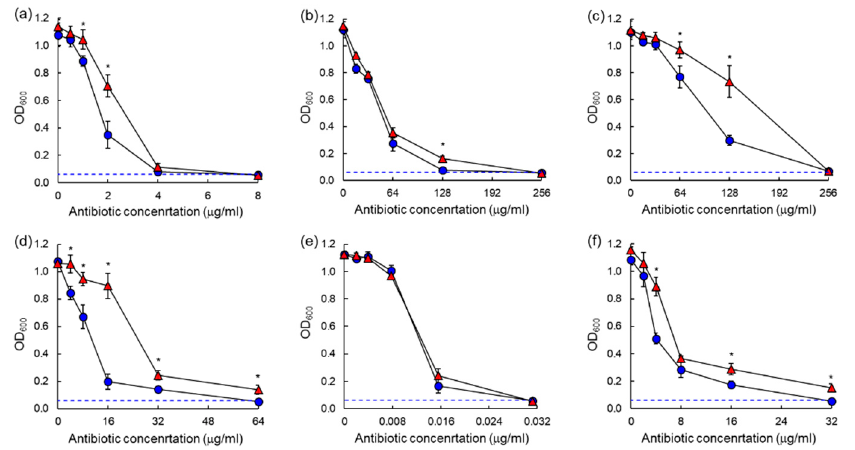
Figure 4. Dose–response curves of antibiotic-sensitive Salmonella Typhimurium CCARM 8009 (ARST) exposed to different concentrations of chloramphenicol ( a ), erythromycin ( b ), tetracycline ( c ), cephalothin ( d ), ciprofloxacin ( e ), tobramycin ( f ) after 20 h ( • ) and 40 h ( (cid:78) ) of incubation. * indicates the significant difference within MIC at p <